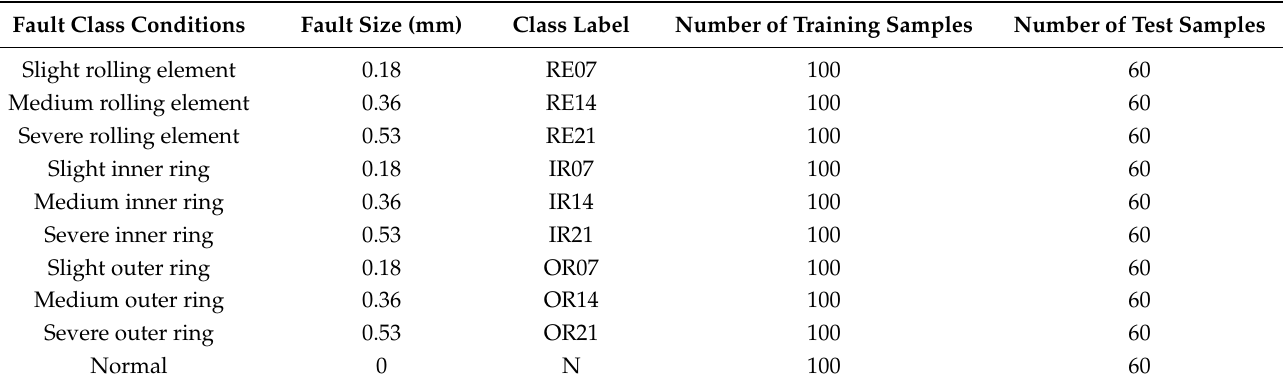
Table 1. Detailed statistics of Dataset